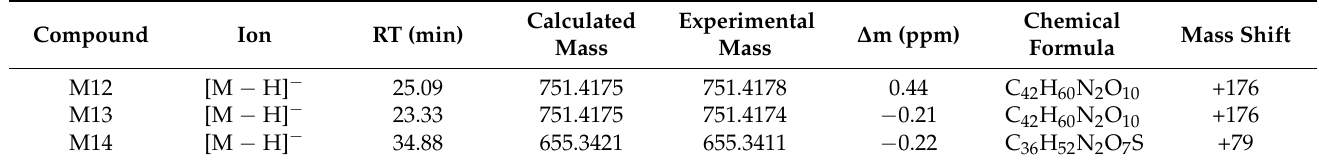
Table 2. Phase II putative metabolites of UniPR129 in liver microsomes and S9